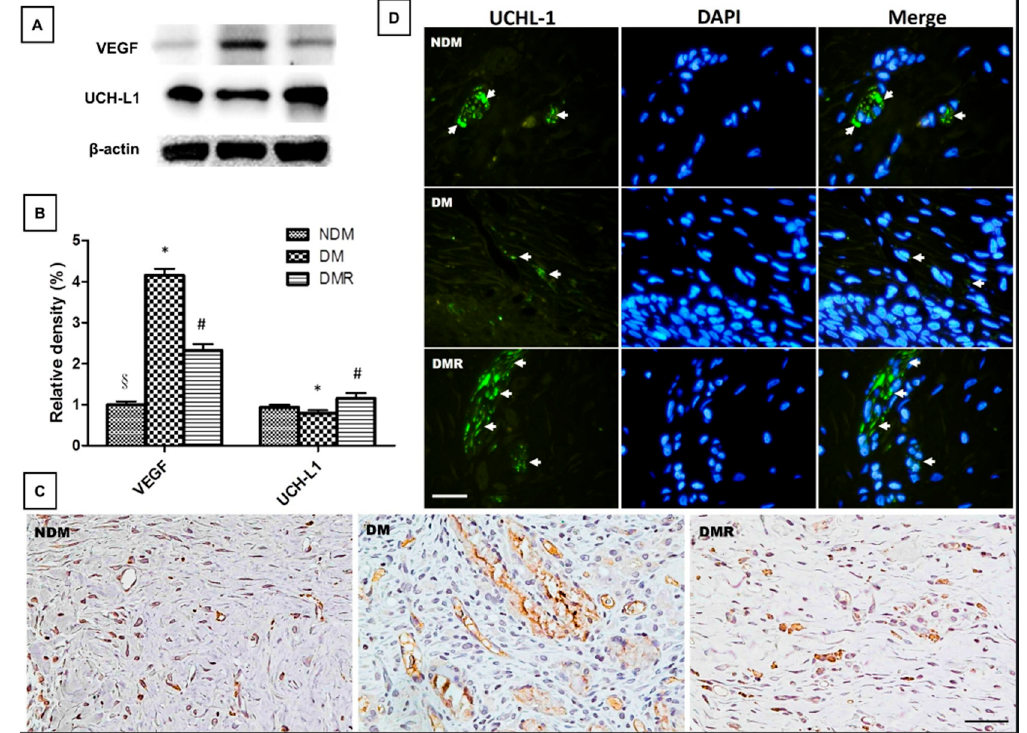
Figure 8. The expression of growth factors was analyzed by Western blotting ( A , B ). Distributions of VEGF ( C ) and UCH-L1 ( D ) expressions based on immunohistochemistry and immunofluorescence staining results. Brown represents positive staining for VEGF in NDM, DM and DMR cytoplasms (magnification, ×200). UCH-L1 immunofluorescence staining of wounds in NDM, DM, and DMR groups on day 21. Nerve fibers stained with UCH-L1 exhibited small single varicosities in DM group in the area of re-epithelialization. UCH-L1-immunoreactive nerve fibers in the NDM and DMR groups were expressed in cross and longitudinal sections of large nerve bundles. Arrows indicate UCHL-1 positive nerve fibers (green, UCH-L1-nerve fiber; blue, DAPI) (magnification, ×400). * p < 0.05 DM compared with the NDM group, § p < 0.05 DMR compared with the NDM group, # p < 0.05